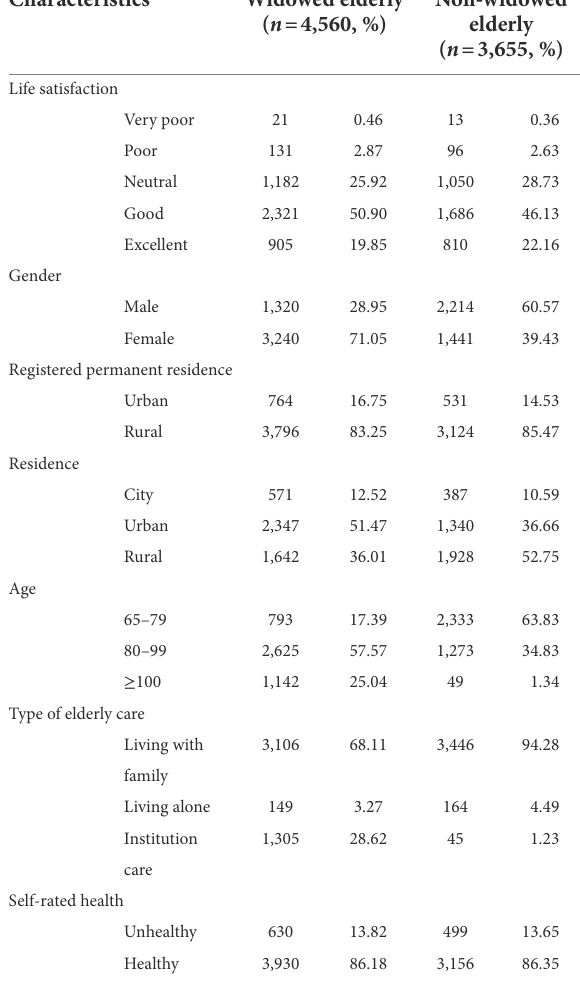
TABLE 2 Descriptive statistics.